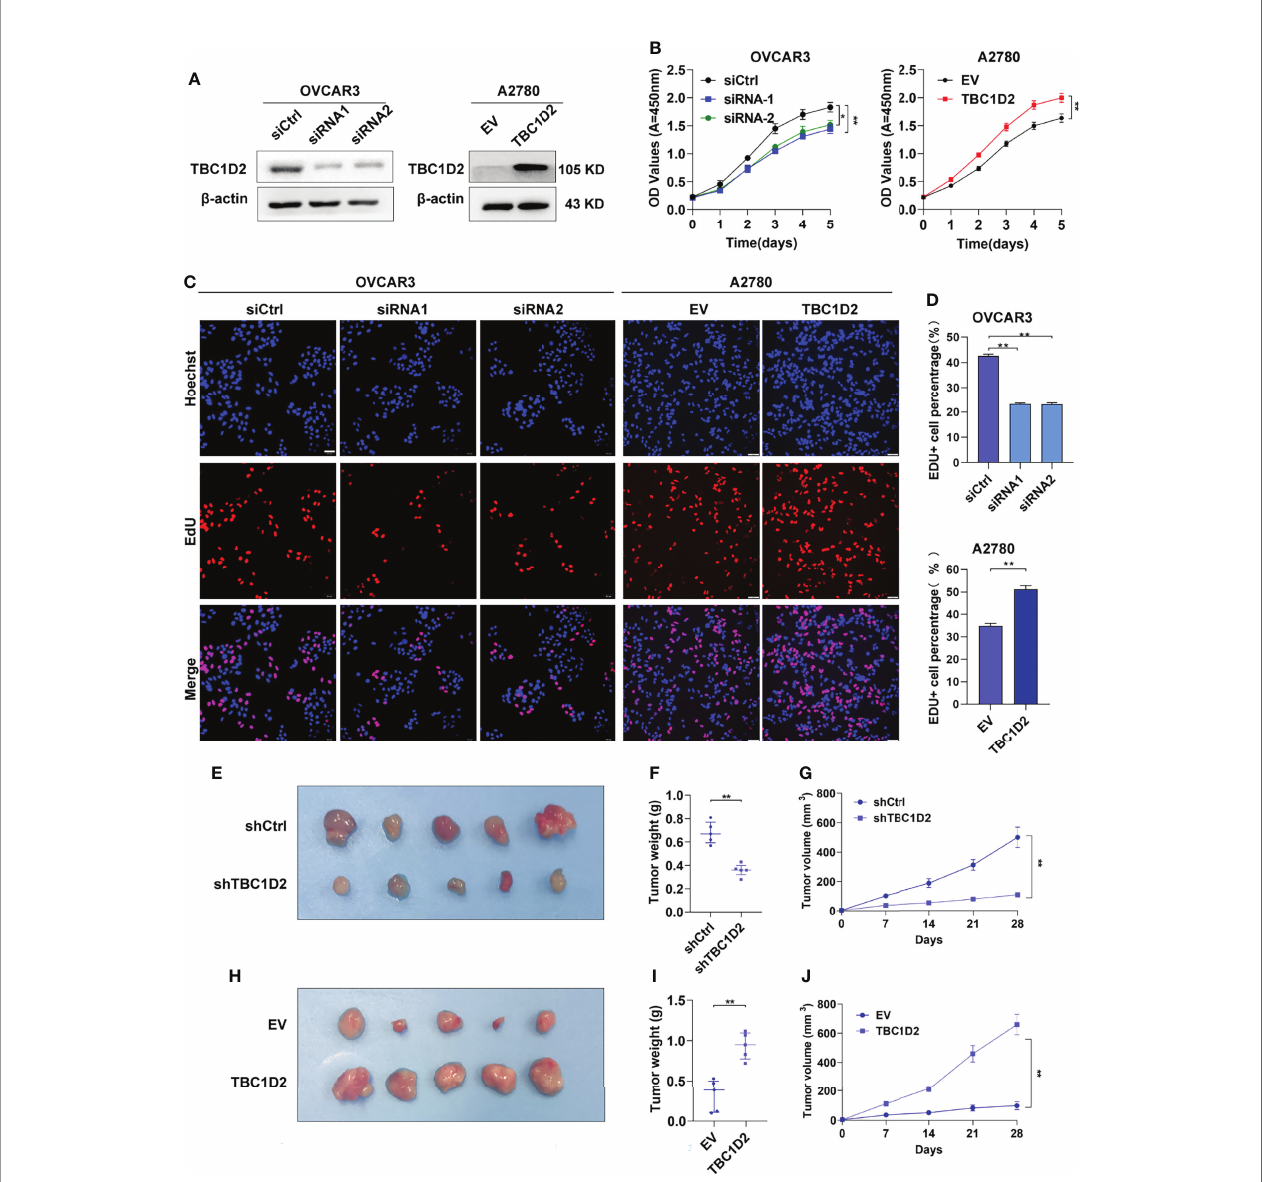
FIGURE 2 | TBC1D2 prompts the proliferation of ovarian cancer cells in vitro and tumor growth in vivo . (A) Western blotting images of TBC1D2 in OVCAR3 and A2780 cells treated as indicated. siRNA1 or siRNA2, siRNA against TBC1D2; siCtrl, control siRNA; EV, empty vector; TBC1D2, overexpression vector encoding TBC1D2. (B) Growth curves of ovarian cancer cells treated as indicated. (C – D) EdU incorporation assays were performed to assess the proliferation ability of OVCAR3 and A2780 cells treated as indicated. Scale bars, 50 m m. (E, H) Photographs of nude mouse xenografts generated by subcutaneous injection of OVCAR3 cells or A2780 cells treated as indicated; n = 5/group. (F, I) Tumor weights were measured and analyzed 28 days after injection. (G, J) Tumor volume curves of subcutaneous xenograft models from OVCAR3 cells or A2780 cells treated as indicated. Tumor volume was measured using vernier calipers every 7 days after subcutaneous implantation. Two-tailed Student ’ s t tests were used to determine the signi fi cance of differences between two groups; data are represented as mean ± SEM. *P<0.05,